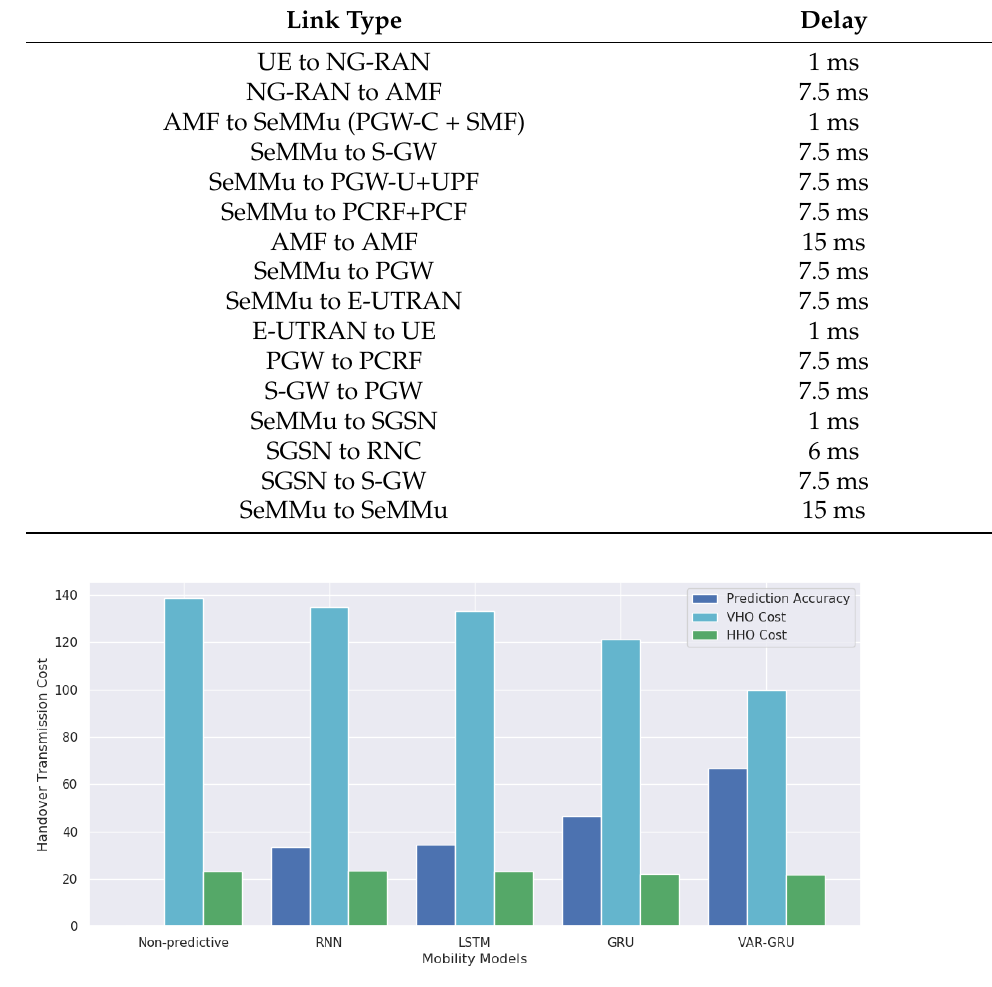
Figure 7. Handover transmission